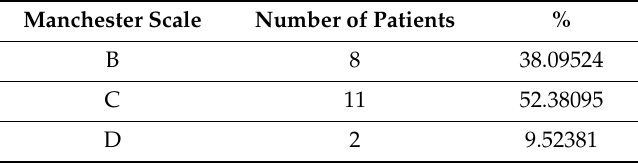
Table 1. The characteristics of the valgus of the exercised foot according to the Manchester scale.